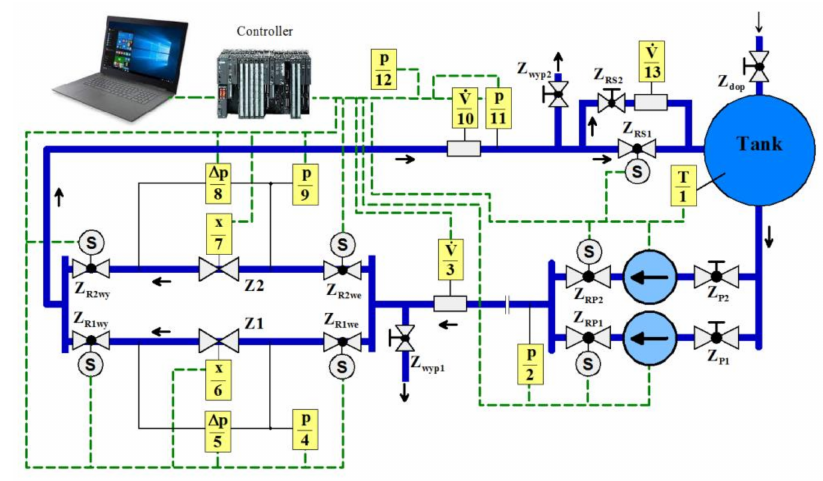
Figure 5. Diagram of the research stand for determining the flow characteristics of